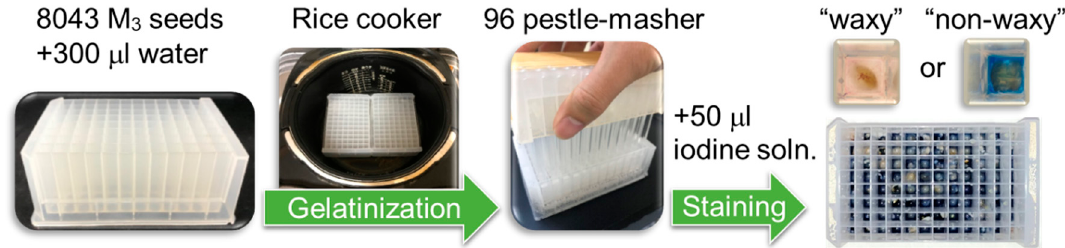
Figure 1. High-throughput screening of waxy mutants from TILLING (Targeting Induced Local Lesions IN Genomes) population. One grain of individual M 3 seed is placed in each well of 96 deep-well plates and 300 mL of water is added. Seeds are gelatinized with a commercial rice cooker and immediately mashed with a bench-made 96 pestle-masher. After cooled to room temperature, 50 µ L of iodine solution is added. The seeds of waxy mutants turn reddish-purple.